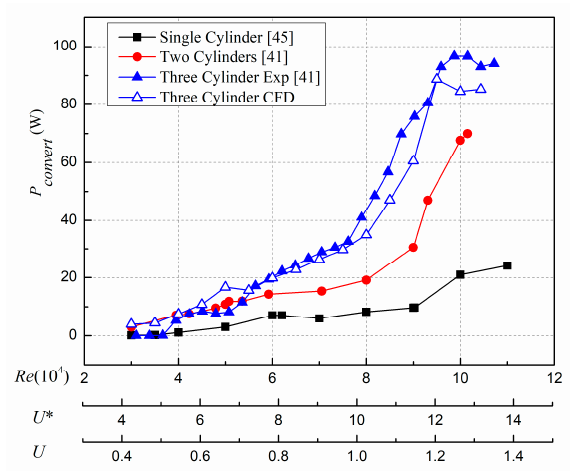
Figure 6. Total power harvesting.